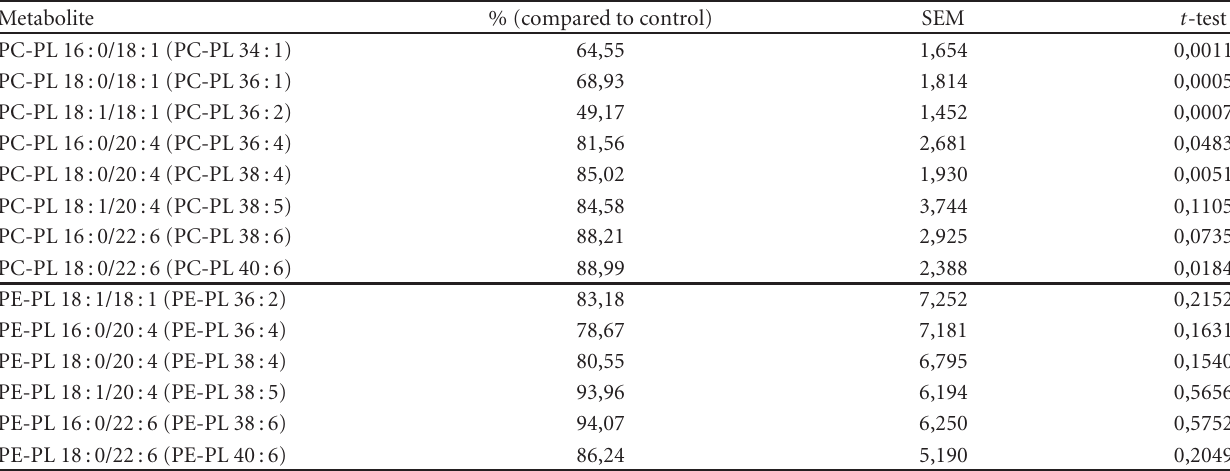
Table 2: Analyzed PC-PL and PE-PL species in human AD postmortem brains compared to healthy individuals. Levels of all analyzed PC- PL and PE-PL species were reduced in human AD postmortem brains. Statistical significance was determined by two-tailed Students t -test. SEM = standard deviation of the mean.